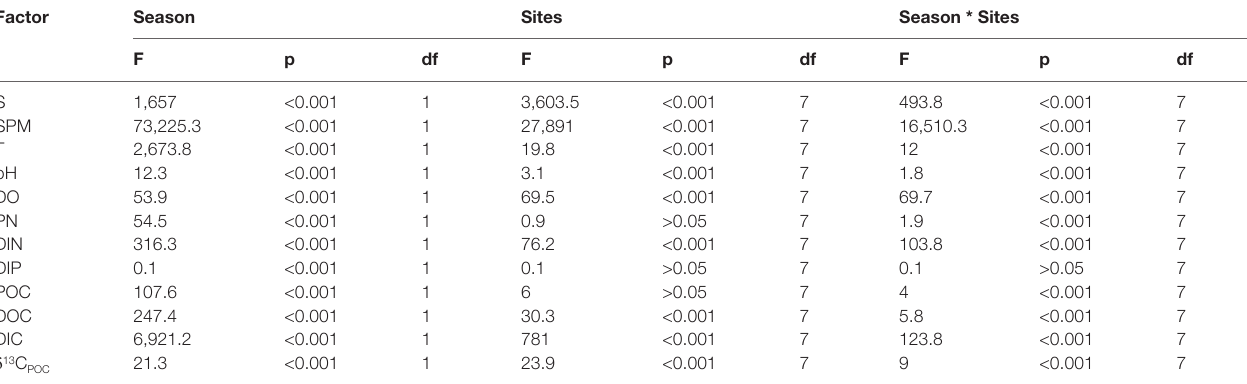
TABLE 2 | Two-way ANOVA results of site and season on carbon and physicochemical properties. Factor Season Sites Season *